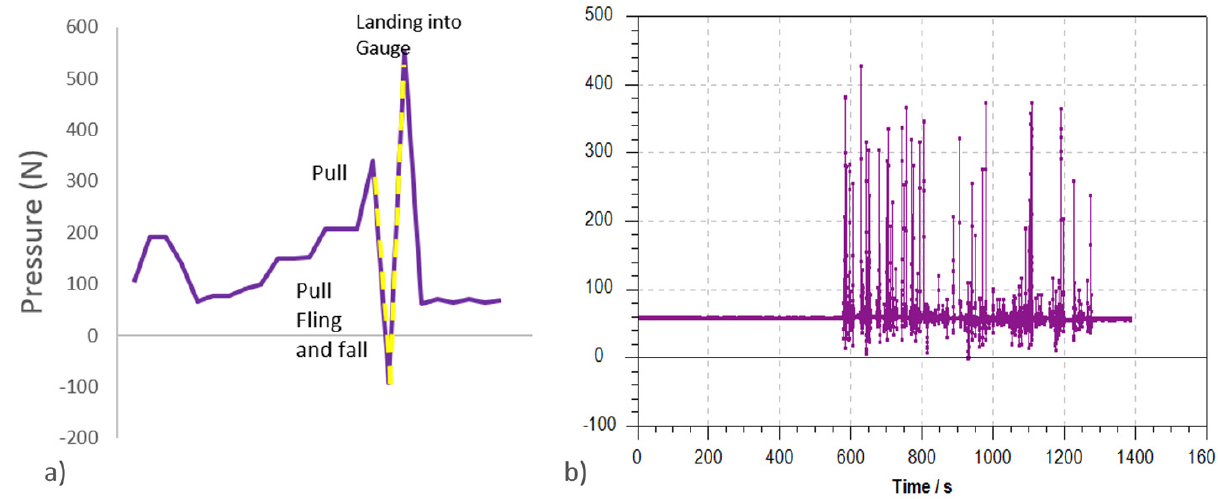
Figure 3. ( a ) Illustration of pressure gauge reading prior to data adjustment showing continued pull slinging up haynet (no pressure to negative push pressure) and sudden drop of haynet as forage is released followed by a sudden high reading as net drops into gauge and; ( b ) Example of corrected pressure readings (once yellow readings from a) have been removed.